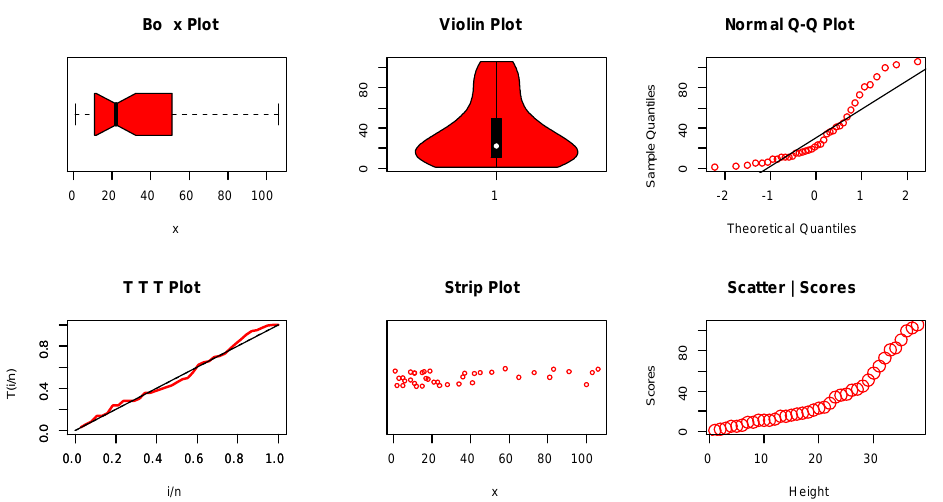
Table 13 lists some numerical accounts of the EDS for LR data. Table 13 . The EDS for LR data. Approach 5 : 998 The ME approach work quite well besides the MLE technique for estimating the unknown parameter. The LR data is su⁄ering from over-dispersed phenomena. Further, the LR data is skewed to the right and leptokurtic.